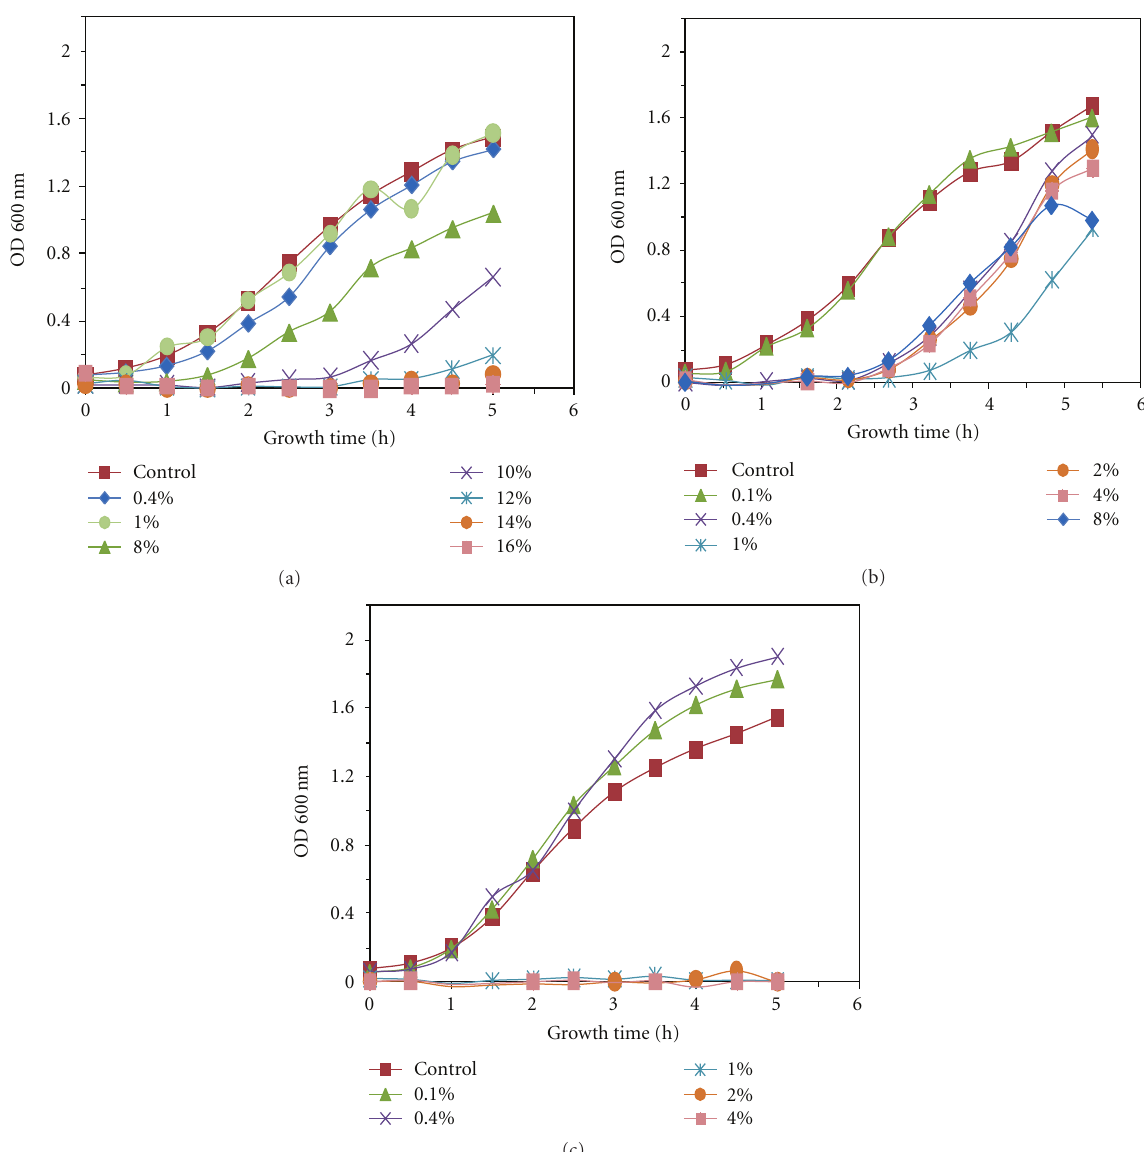
Figure 1: OD growth curves of S. enterica in BHI broth at 37 ◦ C after treatment with surfactant-only solutions and incubation for 1h: (a) treated with 0.4, 1, 8, 10, 12, 14, and 16% SC; (b) treated with 0.1, 0.4, 1, 2, 4, and 8% SDS, and (c) treated with 0.1, 0.4, 1, 2, and 4% SDBS. Controls were cells without surfactant treatments. A blank was used before each reading. Blanks were samples without cells or